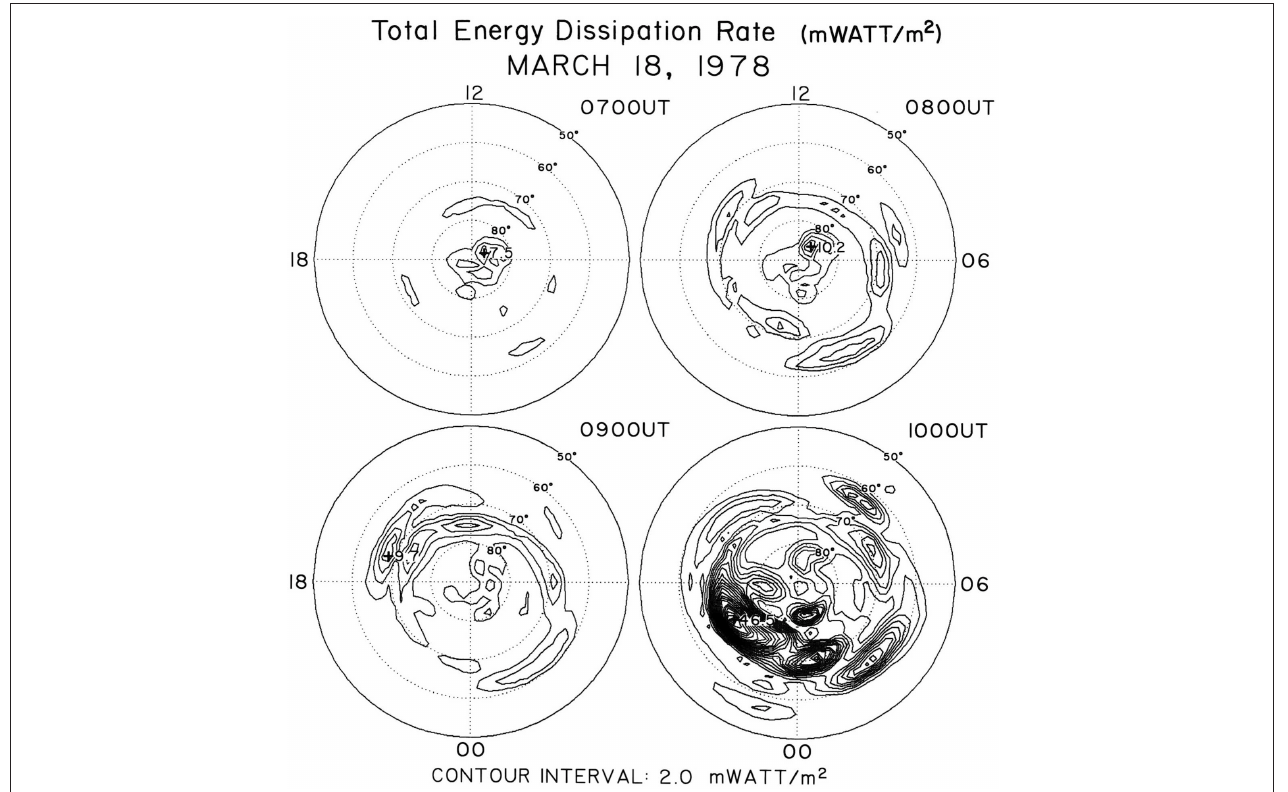
FIGURE 14 | An example of the development of the Joule heat production rate δ (mw/m 2 = erg/s) from the beginning to the maximum epoch during a substorm ( Akasofu, 2017a).